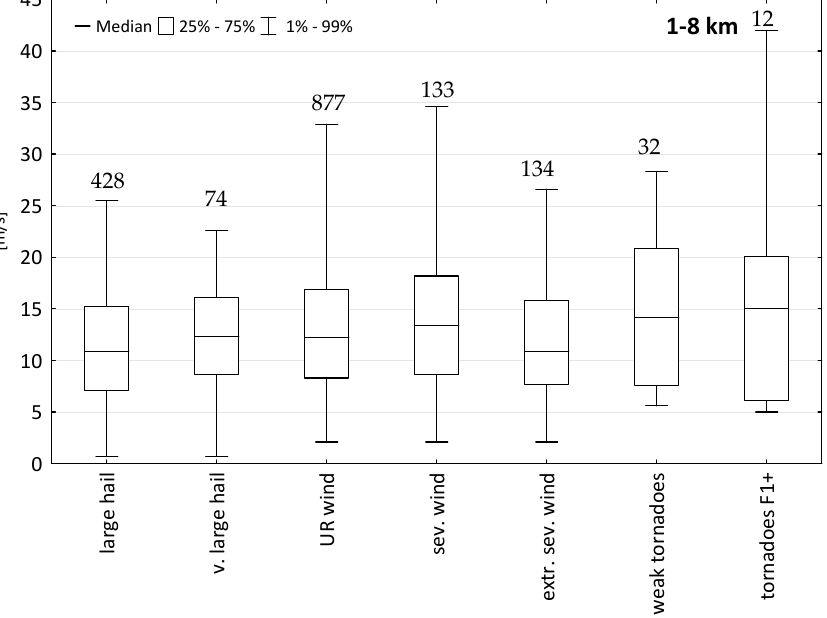
Figure 7. As in Figure 2, except for the 1–8 bulk wind shear.